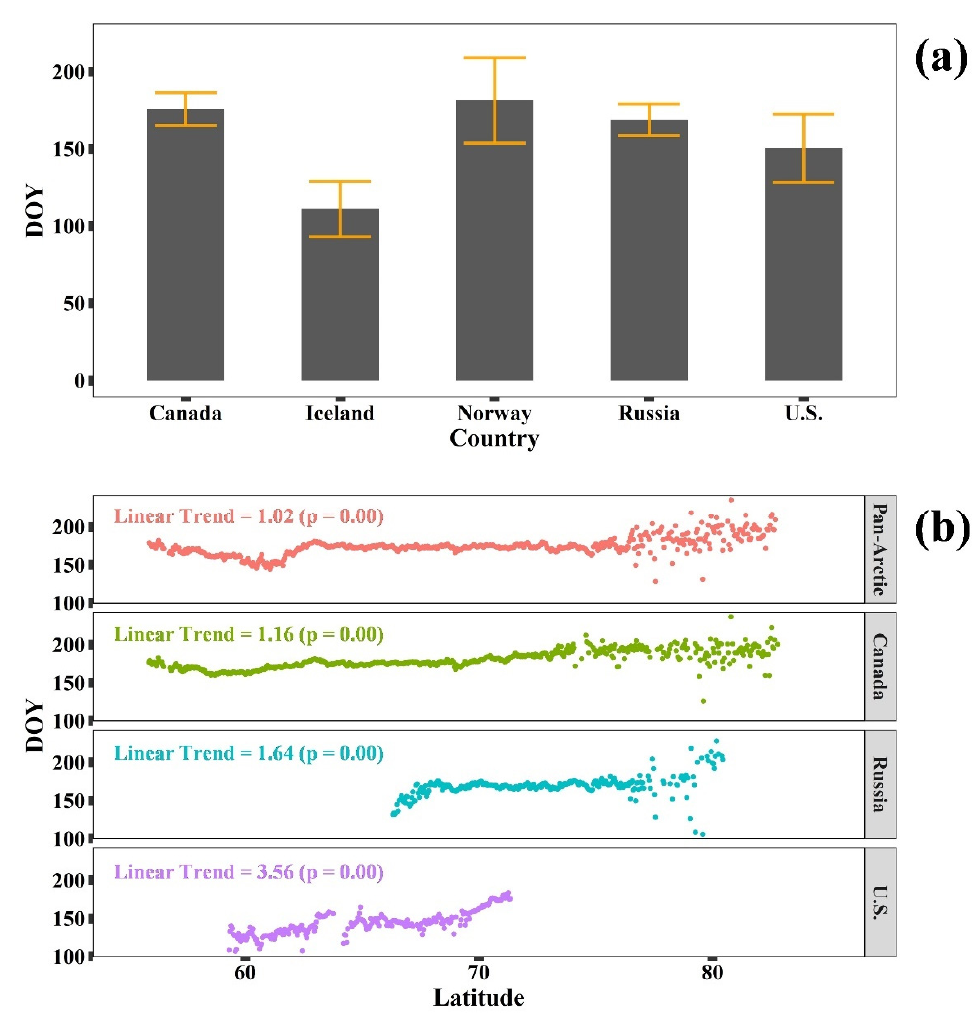
Figure 9. Geographical distribution of Pan-Arctic lake ice BUE. ( a ) Country-level statistics; ( b ) latitudinal profile, derived with an interval of 500 m.